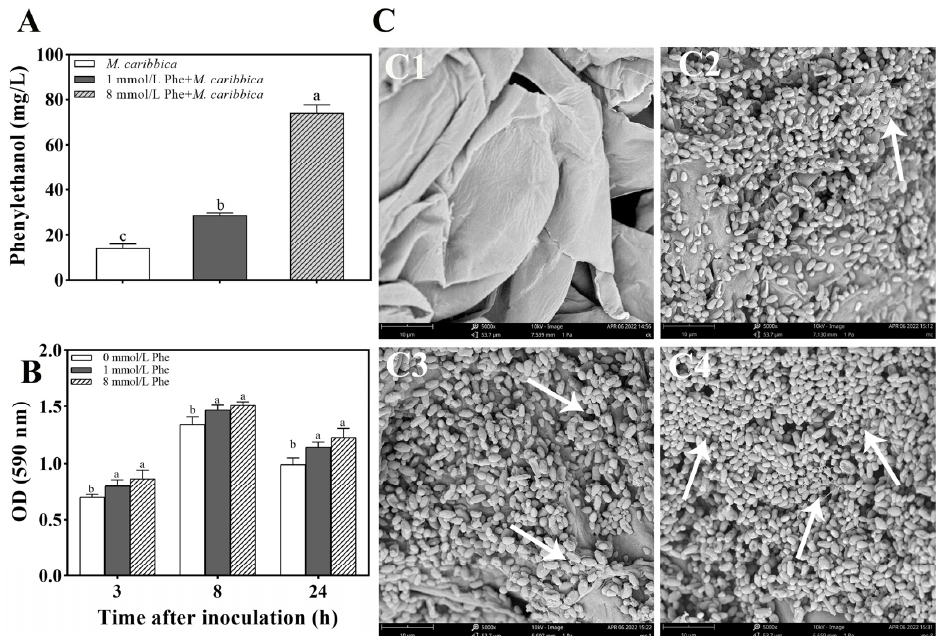
Figure 7. Effect of Phe on phenylethanol production and biofilm formation of M. caribbica . ( A ) Influence of different Phe concentrations on the phenylethanol content produced by M. caribbica . The vertical bar denotes the standard deviation of the mean. ( B ) Influence of different Phe concentrations on biofilm formation of M. caribbica. ( C ) SEM of jujube wound tissues 48 h after inoculation. Wounds were incubated with ( C1 ) SDW, ( C2 ) M. caribbica , ( C3 ) M. caribbica obtained from NYDB medium with 1 mmol/L Phe, and ( C4 ) M. caribbica obtained from NYDB medium with 8 mmol/L Phe. ( C1 – C4 ): magnification of 5000×. White arrows indicate the extracellular matrix secreted by M.caribbica . Error bars indicate the standard deviation, and different letters indicate significant differences ( p < 0.05).